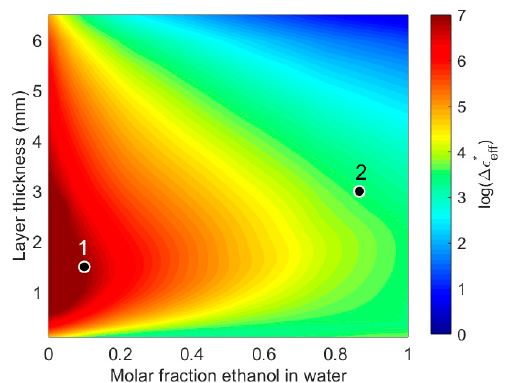
Figure 6. Plot of permittivity difference between simulated effective permittivity and empirical model as calculated by Equation (3). The frequency responses for the liquid layers marked 1 and 2 are shown in Figure 5a,b, respectively.